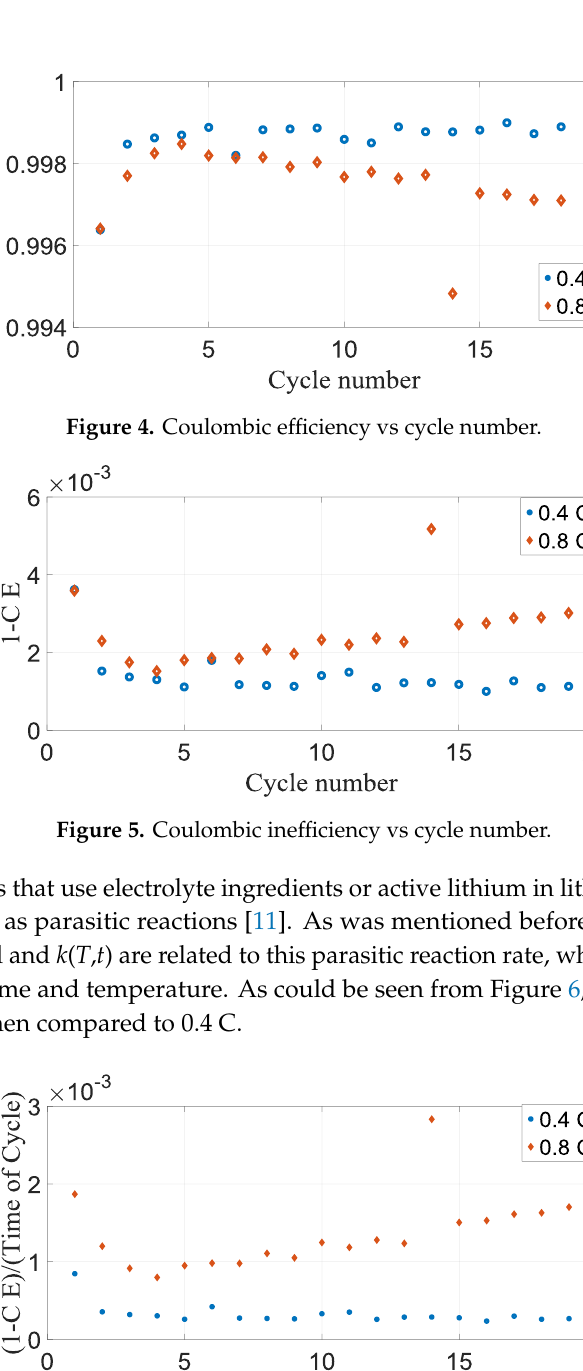
Figure 4. Coulombic efficiency vs cycle number.